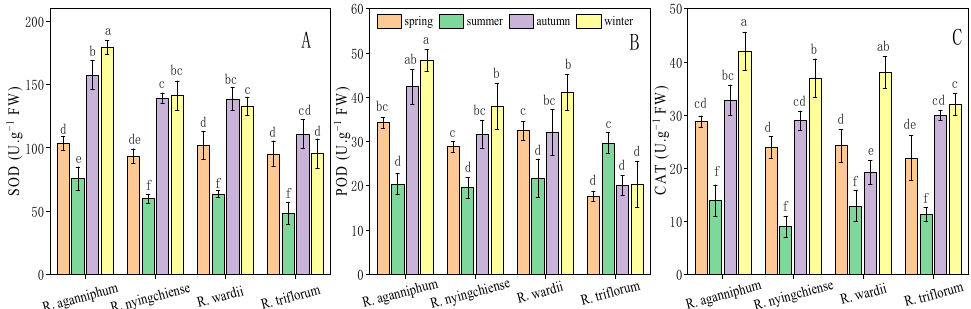
Figure 2. Protective enzyme SOD ( A ), POD ( B ), and CAT ( C ) activity of four Rhododendrons in different seasons under subalpine habitat on Sygera mountain of the QTP. Values are expressed as mean ± SE ( n = 9), and lowercase letters represent the significant differences among the four Rhododendrons in four seasons ( p < 0.05).